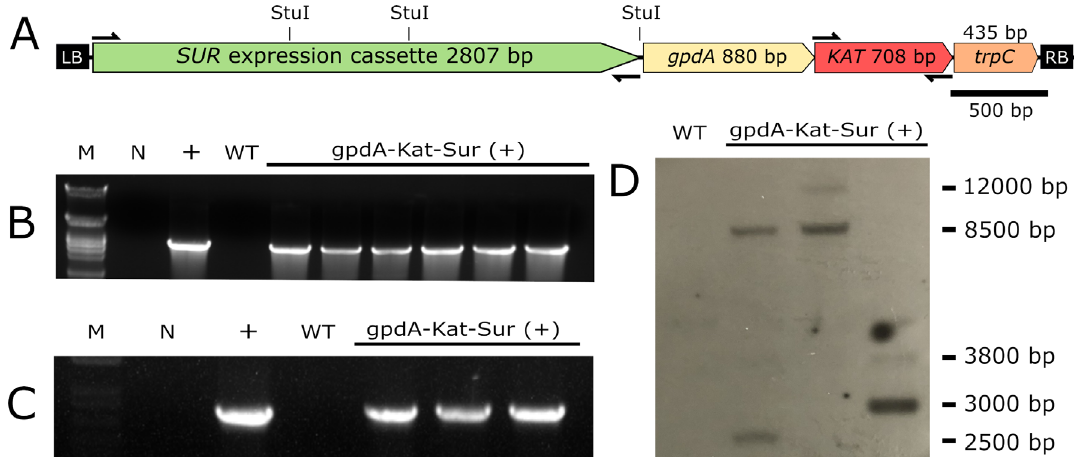
Figure 5 ‒ Evaluation of the SUR gene and Kat expression cassette stability in the S. subtropicum mutants. Selected S. subtropicum mutants with the brightest far-red Kat-fluorescence were cultivated for five generations in MCc without CE to evaluate the mitotic stability. A) The Kat gene expression cassette (gpdA::Kat::TrpC) was cloned next to the SUR expression cassette (as displayed) in the plasmid pPZP201BK::SUR, to generate the plasmid pPZP201BK::SUR::gpdA::Kat::TrpC. B) The PCR results amplifying the SUR gene (~2800 bp). C) The PCR results amplifying the KAT CDS (~700 bp). D) The Southern blotting results employing the KAT CDS as a probe. M – DNA Ladder; N – Negative control (without DNA); + – pPZP201BK::SUR::gpdA::Kat::TrpC plasmid; WT – S. subtropicum wild-type strain; gpdA-Kat-Sur (+) – S. subtropicum mutant strains harboring the Kat gene expression cassette and the SUR gene integrated into the